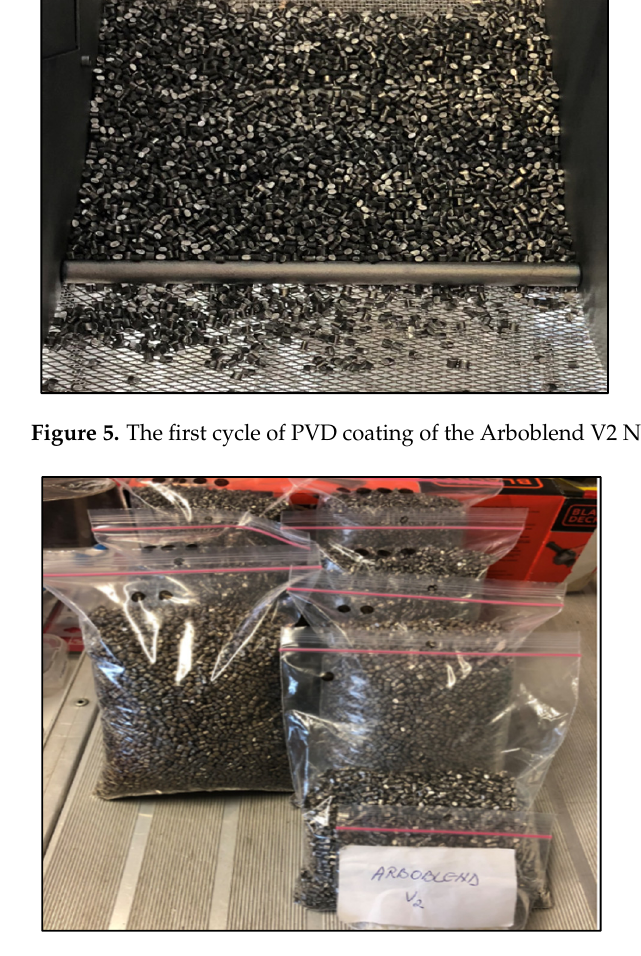
Figure 6. The results after finishing all five cycles of silver nano-coating .